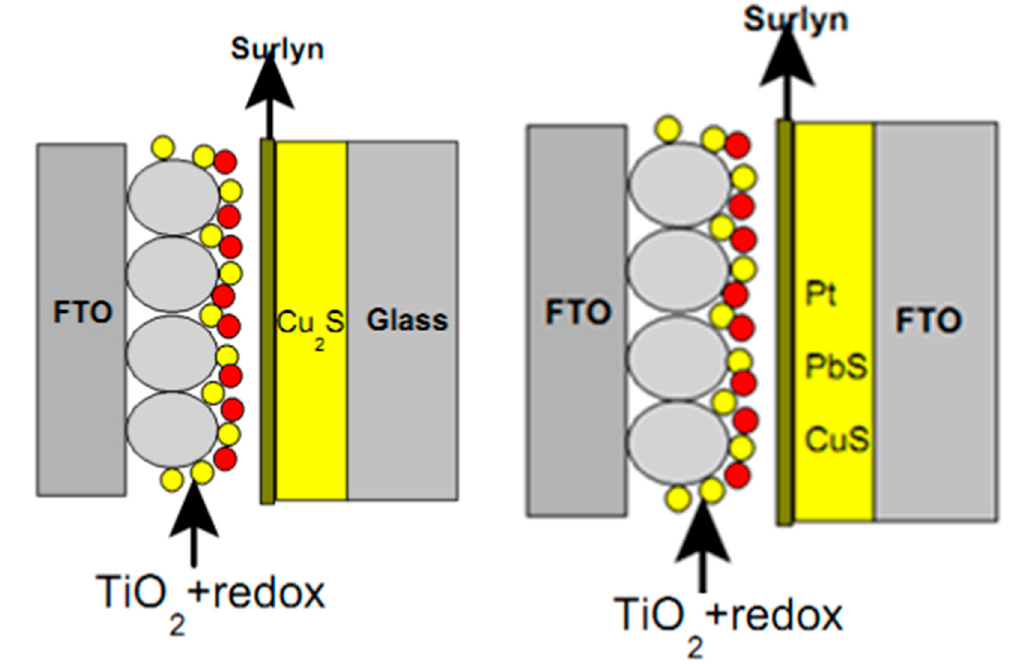
Figure 9. Schematic diagram of QDSSCs’ structure with different counter electrode materials: Cu 2 S ( left ) and Pt, CuS, and PbS ( right ).